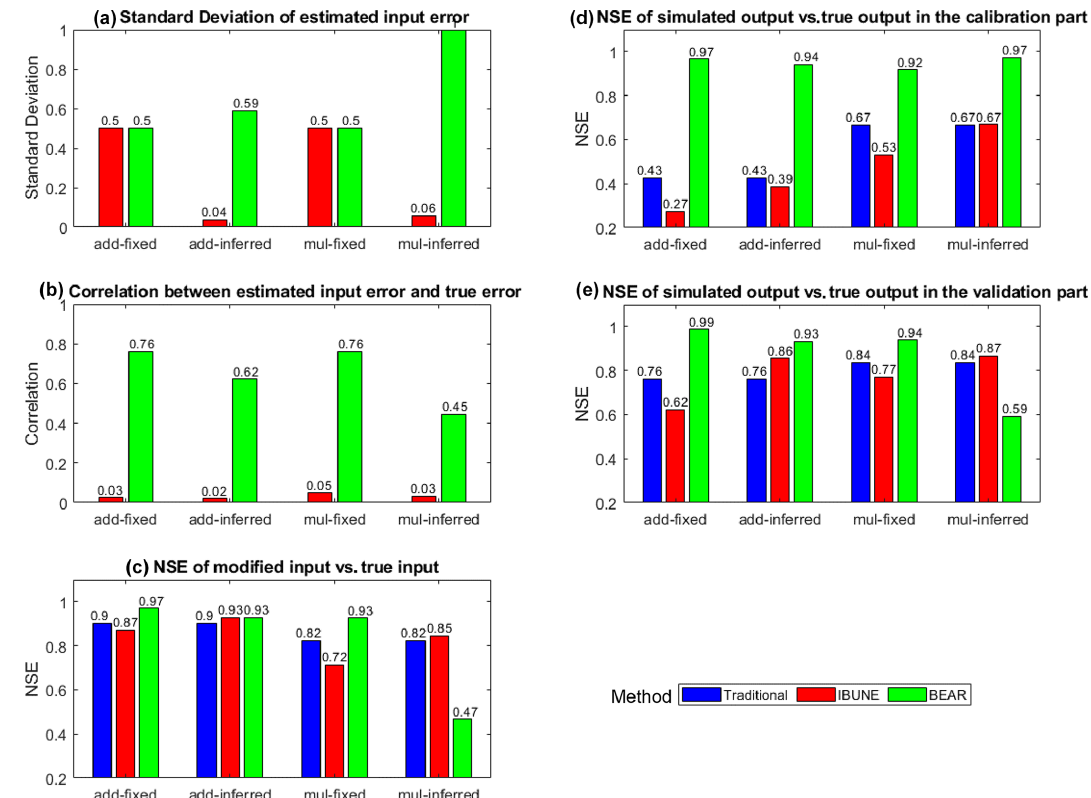
Figure 2. Comparison of the statistical characteristics of four calibration scenarios in synthetic case 1 (including add-fixed, add-inferred, mul-fixed, and mul-inferred; notations are given in Table 2) via three calibration methods (including the traditional method, the IBUNE method, and the BEAR method; their algorithms are explained in Sect.